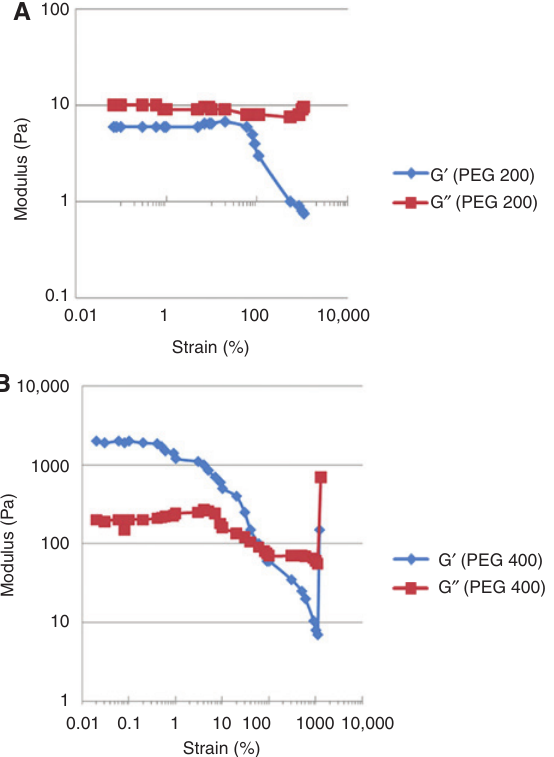
Figure 9: Modulus diagram based on strain percentage for the 15 wt% silica sample in (A) PEG 200 and (B) PEG 400.